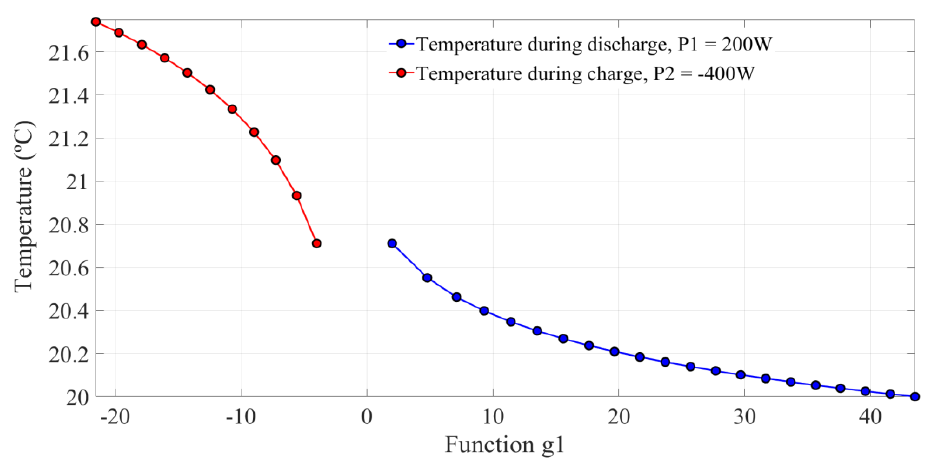
Figure 9. Evolution of the cell temperature as a function of the variable g (cid:2869) .